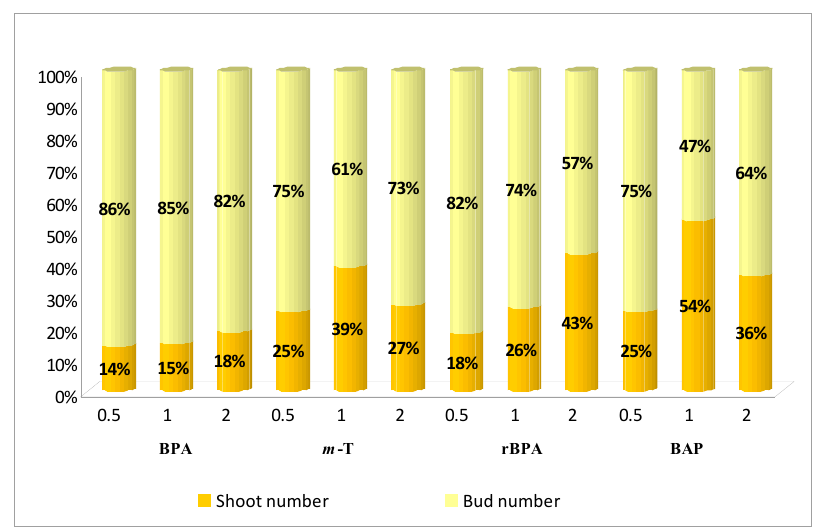
Figure 3. Ratio of shoots to buds of S. viridis formed on MS medium with 0.1 mg/L IAA and different cytokines at different concentrations.